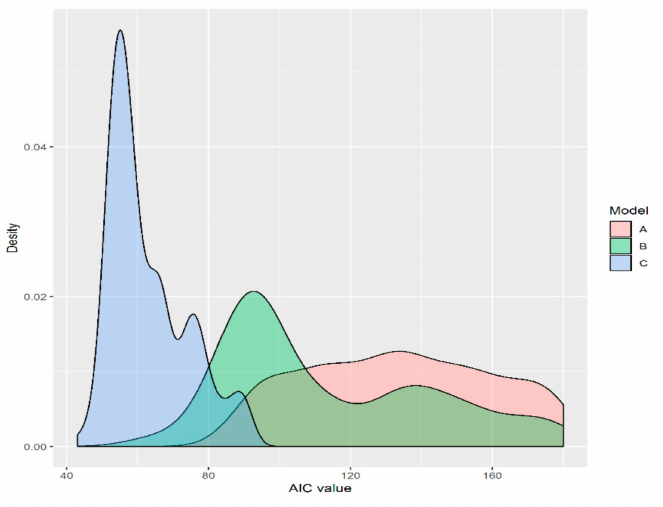
Figure 2. The density distribution of the Akaike information criterion values for three models fitted to the species–area data ( p < 0.001). A: logarithmic model, B: power model, C: logistic